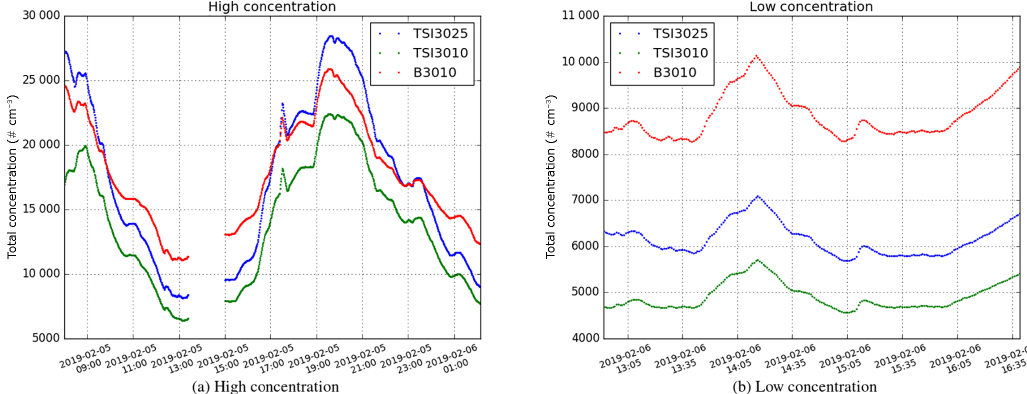
Figure 10. Comparing B3010 with TSI 3025 and TSI 3010 during a high-concentration episode (a) and a low-concentration episode (b) .